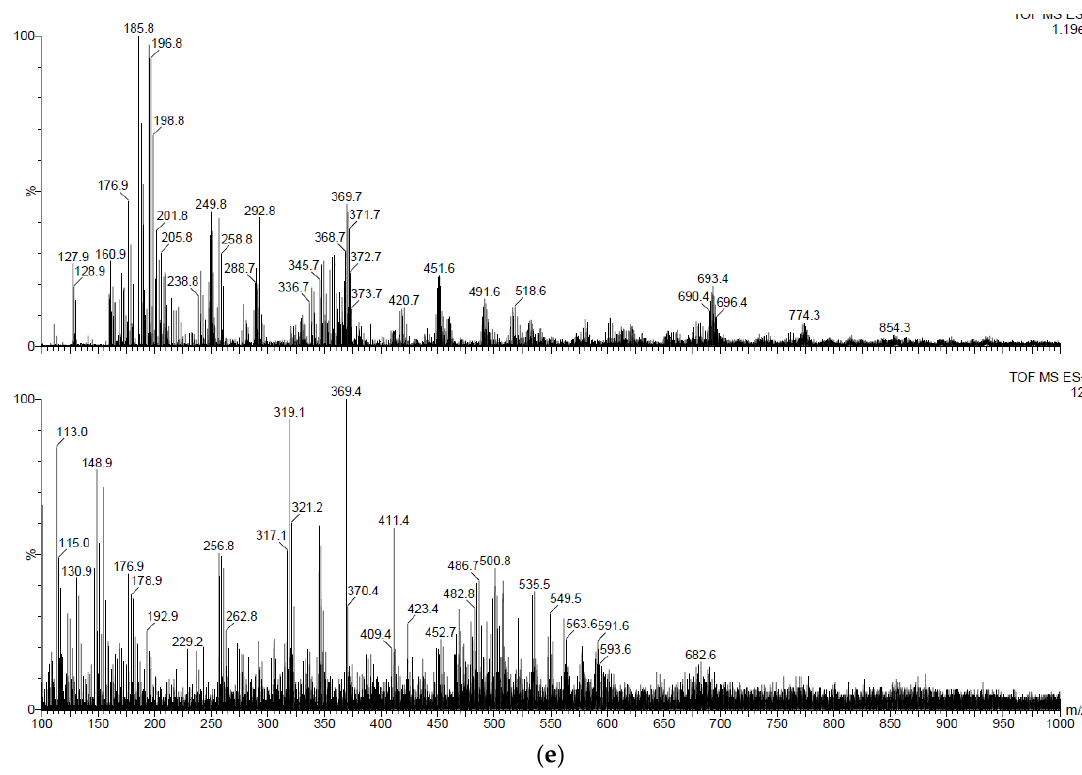
Figure 2. Mass spectrum of degree of complexation of metal ions in the tested products: ( a ) ZnSO 4 ∙ 7H 2 O solution (C ‐ H 2 O ‐ Zn); ( b ) H 10%; ( c ) H 10% ‐ Zn; ( d ) F 100%; ( e ) F 100% ‐ Zn.